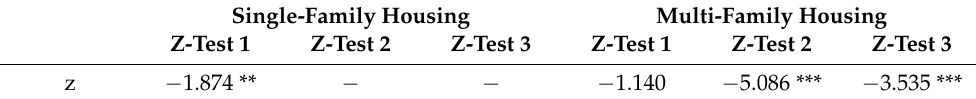
Table 7. Z-tests for coefficients in interaction models